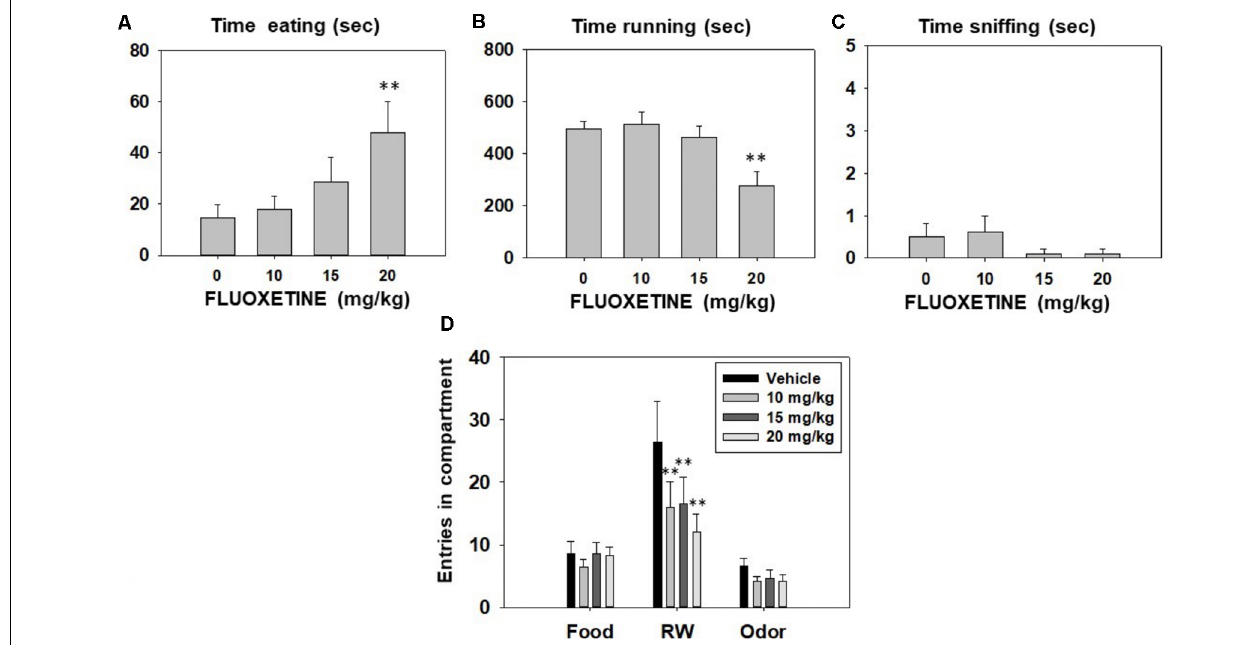
FIGURE 4 | Effect of fluoxetine (Vehicle, 10, 15 and 20 mg/kg) on time eating (A) , time running (B) , time sniffing (C) , entries into compartments (D) , and in the T-maze task assessed during 15 min. Data for each variable were analyzed by repeated measures ANOVA. Bars represent mean ± SEM of accumulated seconds or number of entries. ∗∗ p < 0.01 significantly different from